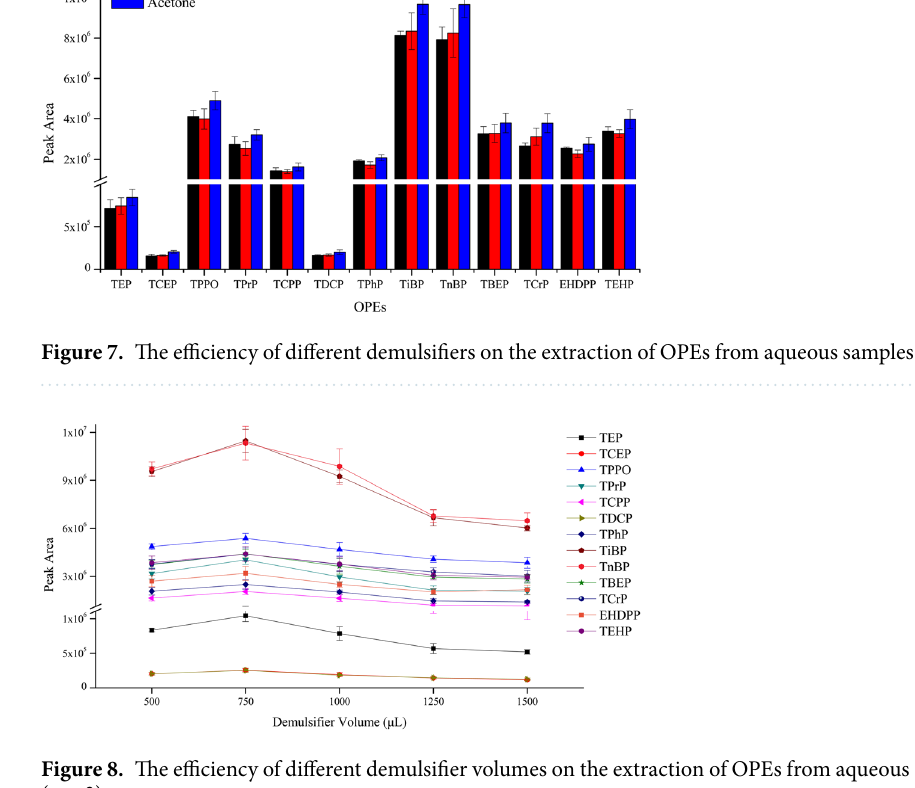
Linear range ( µ g/L)